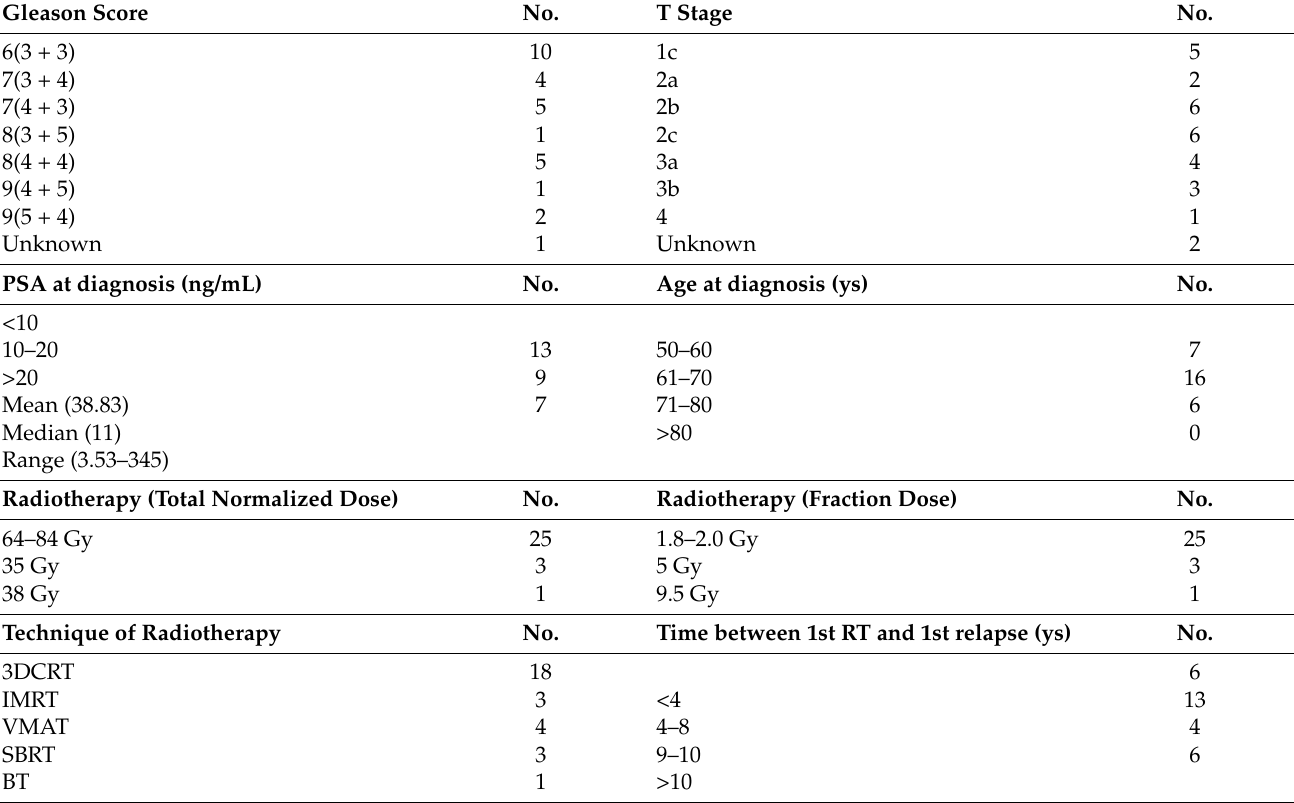
Table 1. Characteristics of patients and of the first radical